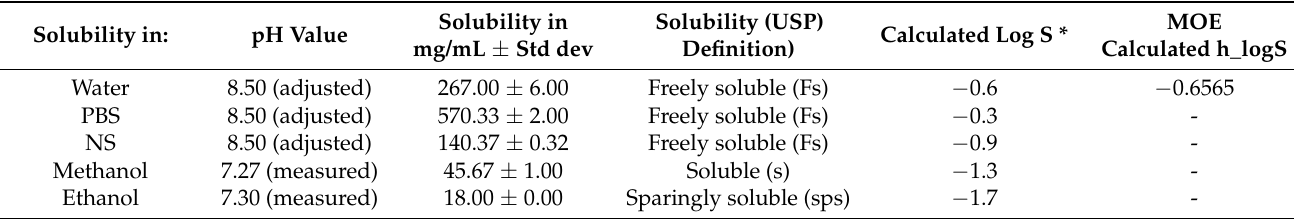
Table 7. Solubility of Lactomorphin in different solvents (mean ± standard deviation, n = 3) by experimental and computational methods.